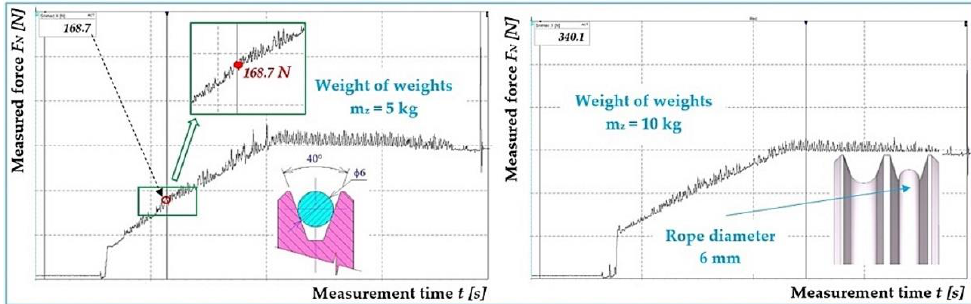
Figure 11. The force waveform of F N measured by RSCC load cell on laboratory equipment.